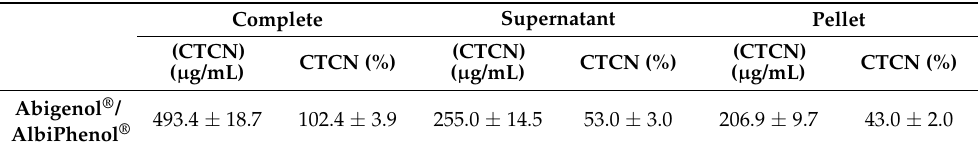
Table 1. Abigenol ® /AlbiPhenol ® catechin (CTCN) content at the end of the processing phase and in the supernatant (bioaccessible fraction) and pellet (excreted fraction). Percentages are calculated on the expected catechin concentration at the end of the digestive process. Results are shown as average ± standard deviation of three replicates (n = 3).